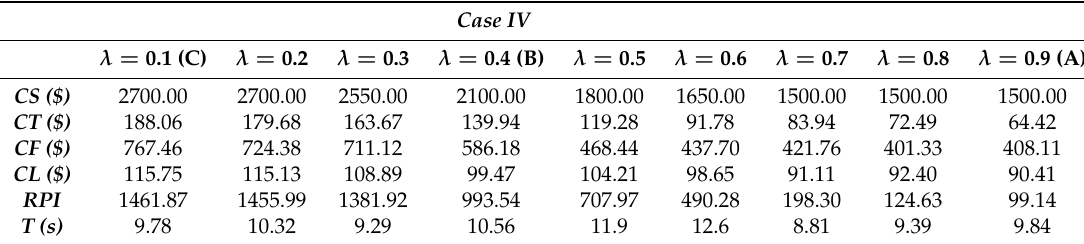
Table 3. Solutions (values: 10 3